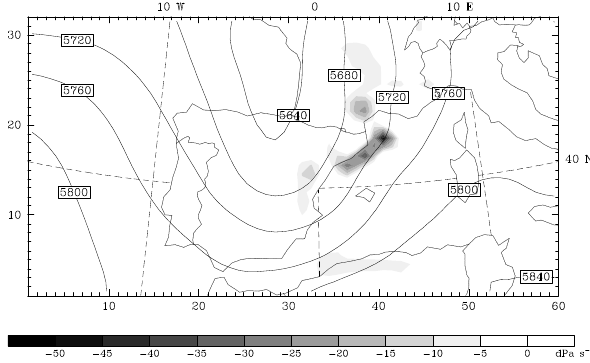
Fig. 4. Geopotential height (continuous line) and upward vertical motions (shaded area) at 500hPa at 19:00